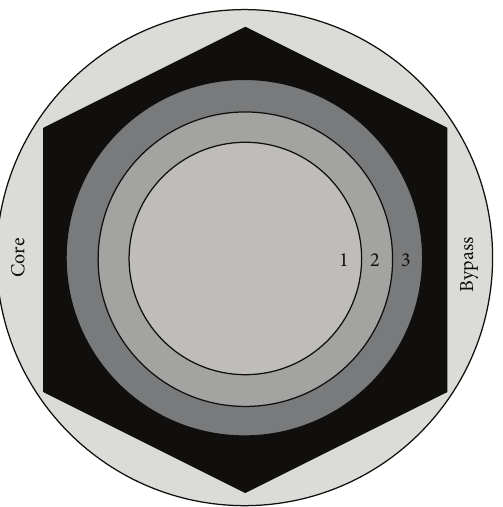
Figure 6: Peak cladding temperature.